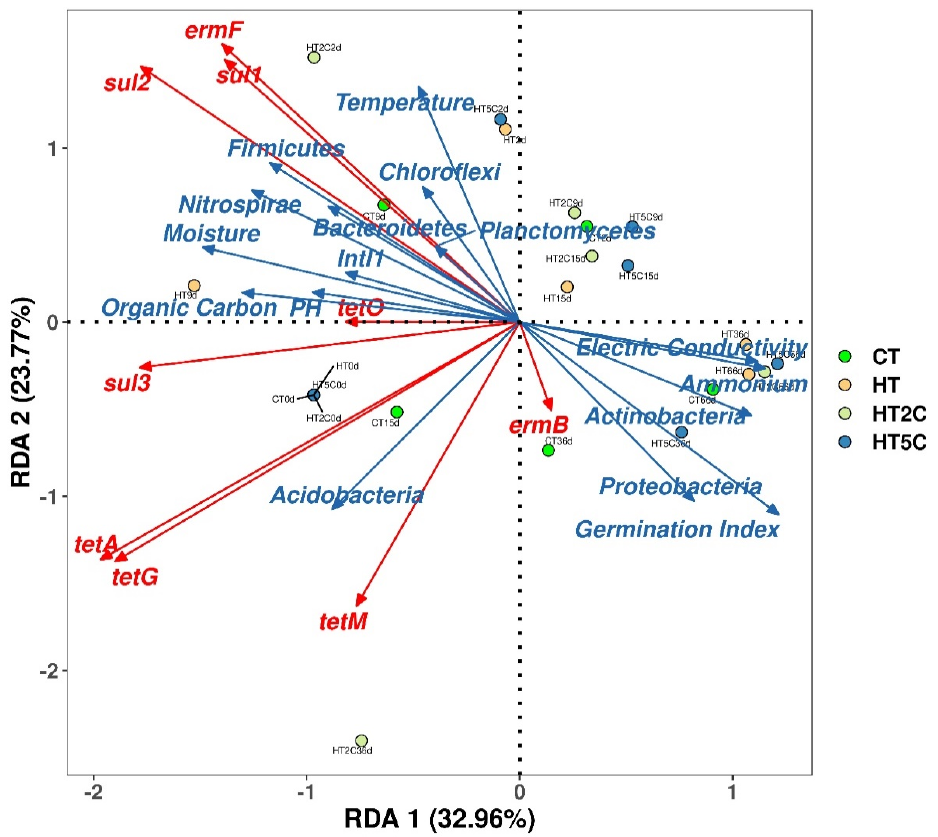
Figure 5. Redundancy analysis based on antibiotic resistance genes (ARGs), the mobile genetic element (MGE), microbial communities and environmental factors.